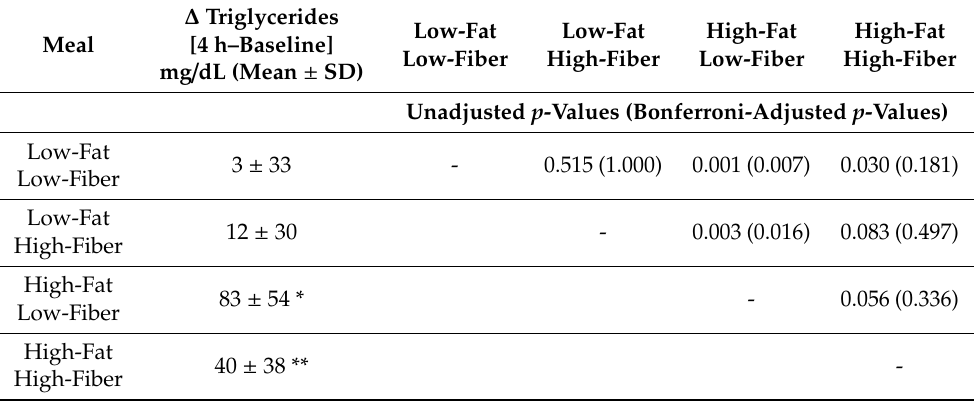
Table 7. Change in plasma triglyceride concentration from baseline to 4 h postprandial: comparison between meals.